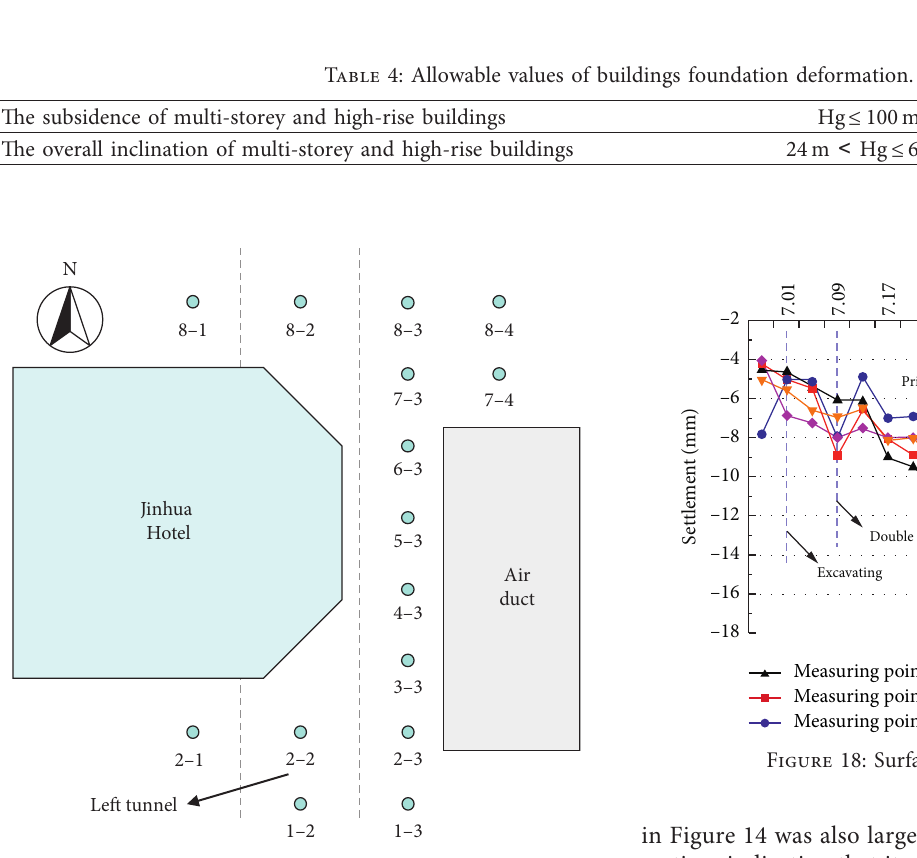
Figure 17: Surface subsidence measuring points.